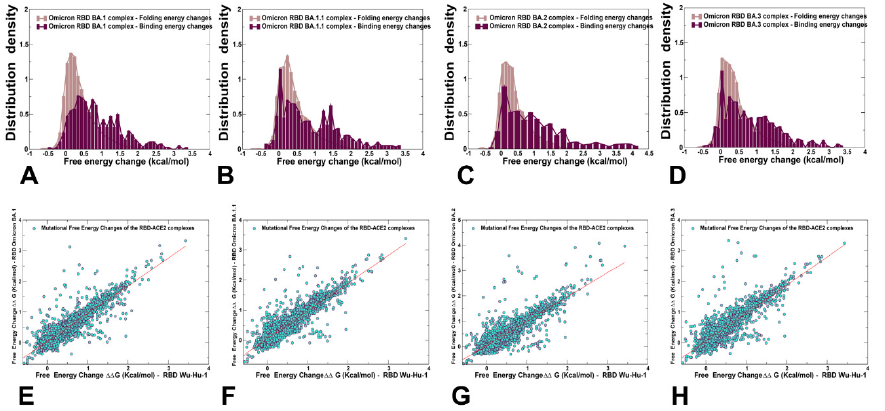
Figure 8. Ensemble-based distributions of the RBD folding free energy changes in the Omicron RBD- complexes based on mutational scanning of all RBD residues (in light brown bars) and biding energy changes based on mutational scanning of the intermolecular residues (in maroon bars). The density distributions are shown for the Omicron RBD BA.1-hACE2 ( A ), Omicron RBD BA.1.1-hACE2 ( B ), Omicron RBD BA.2-hACE2 ( C ), and Omicron RBD BA.3-hACE2 complexes ( D ). The 2D scatter plots of the free energy changes for the RBD residues in the Omicron RBD-hACE2 complexes. The scatter plot of the free energy changes from mutational scanning of the RBD residues in the reference RBD Wu-Hu-1 complex and the Omicron RBD BA.1 complex ( E ), RBD BA.1.1 complex ( F ), RBD BA.2 complex ( G ), and RBD BA.3 complex ( H ). The data points are shown in light-brown colored circles. In general, this analysis suggests that the evolutionary paths for significant improve- ments in the binding affinity of the Omicron RBD variants with hACE2 are relatively nar- row and require balancing between various fitness tradeoffs of preserving RBD stability, maintaining binding to ACE2, and allowing for immune evasion [99]. These factors may severely limit the “evolutionary opportunities” for the virus to adapt new mutations that markedly improve ACE2 binding affinity without compromising immune evasion and stability. These arguments are consistent with the recent realization that evolutionary pressure invokes a complex interplay of thermodynamic factors between mutations that retain or marginally improve affinity for the ACE2 with other RBD modifications facili- tating immune escape. Moreover, the emerging consensus proposed that immune evasion may be a primary driver of Omicron evolution that sacrifices some ACE2 affinity enhance- ment substitutions to optimize immune-escaping mutations [29–33]. 2.5. Dynamic Modeling of the Residue Interaction Networks and Community Analysis of the Omicron RBD Complexes Detail Role of Binding Hotspots in Mediating Epistatic Interaction Effects The evolutionary and functional studies [66–70] suggested that evolutionary win- dows for the Omicron variants could be enhanced through epistatic interactions between variant mutations and the broader mutational repertoire. It was suggested that weak epi- stasis for the Wu-Hu-1 original strain may become more pronounced for the Omicron variants as a potential virus mechanism to counter limited potential for continued evolu- tion [66]. In this section, we employed the ensemble-based modeling of the residue inter- action networks utilizing dynamics and coevolution [100–103] together with community decomposition analysis to propose a topology-based model to characterize non-additive